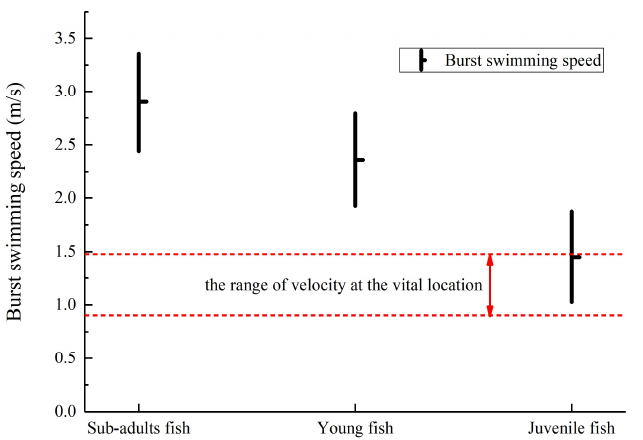
Figure 9. The burst swimming speed of grass carp with different body length .